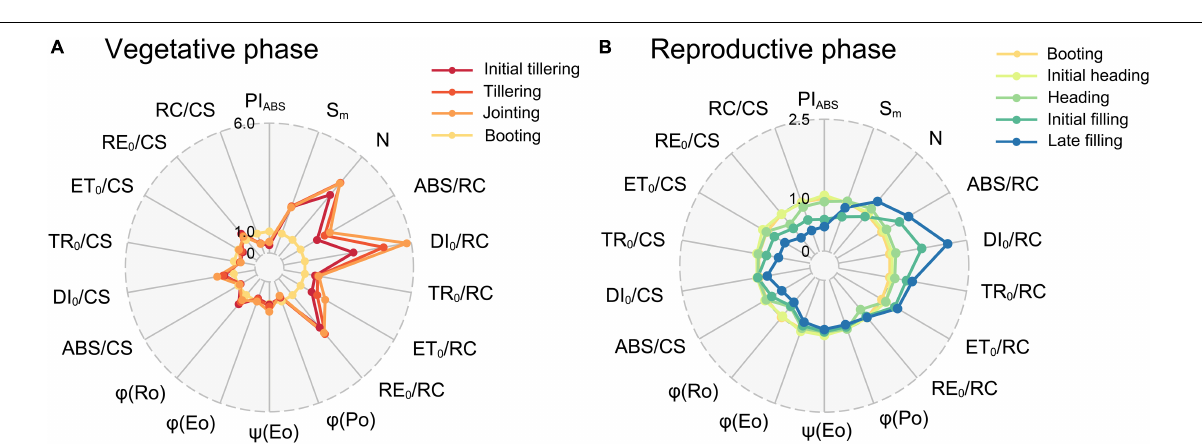
similar to the vertical pattern at the jointing (V3, Figure 4C ) and the late filling (R5, Figure 4H ),